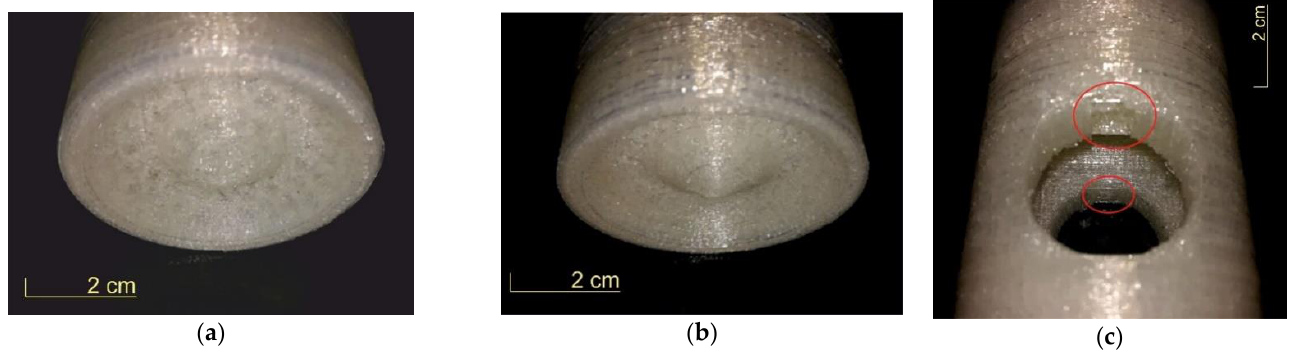
Figure 1. ( a ) Printed engine part with an infill density of 20%, ( b ) the same engine part as at ( a ) with infill density of 30%, ( c ) a bridge that was printed by the software, the authors did not design this.